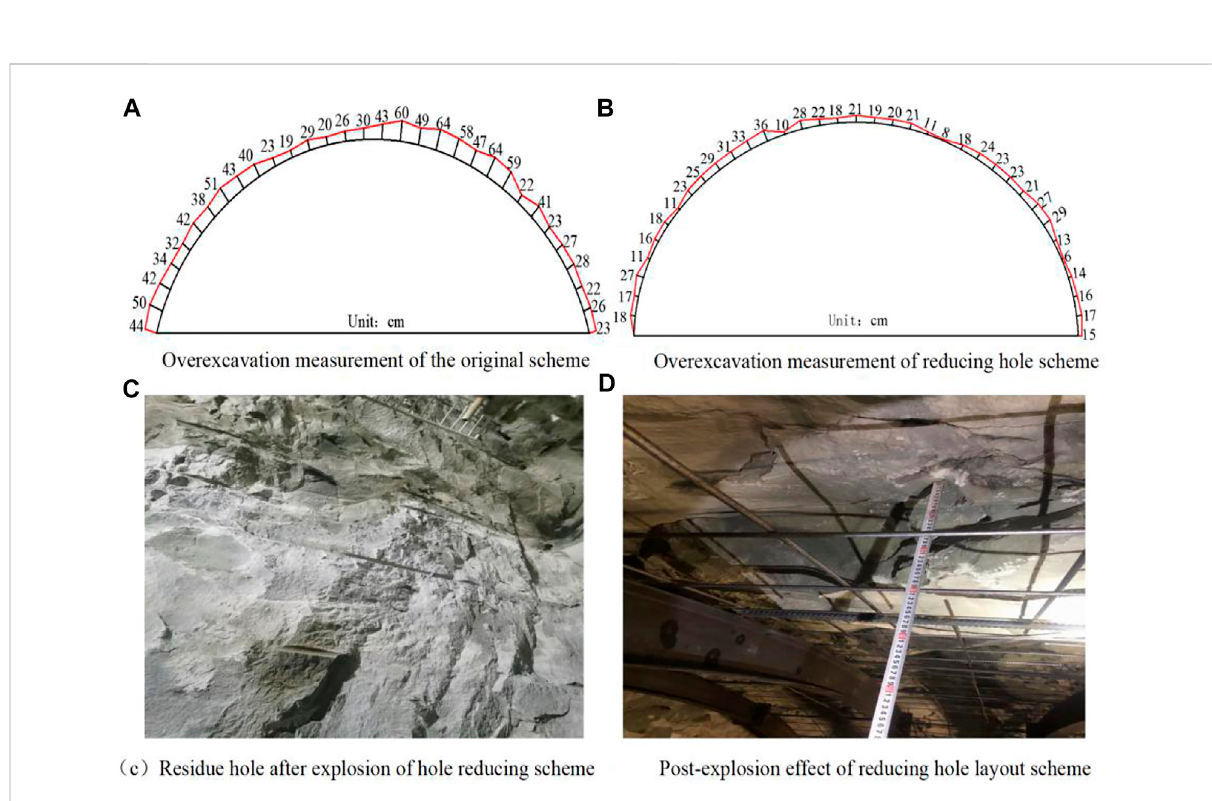
FIGURE 18 Damage diagram of the post-explosion